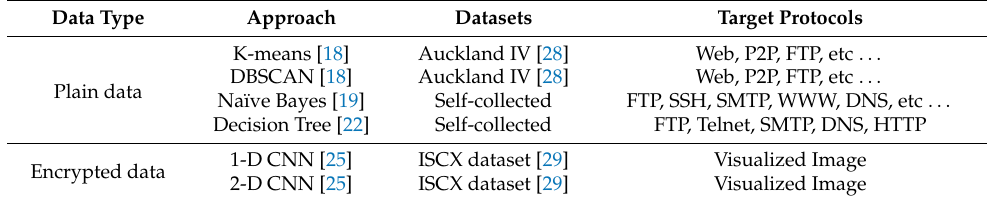
Table 1. State-Of-Art Traffic Classification Method